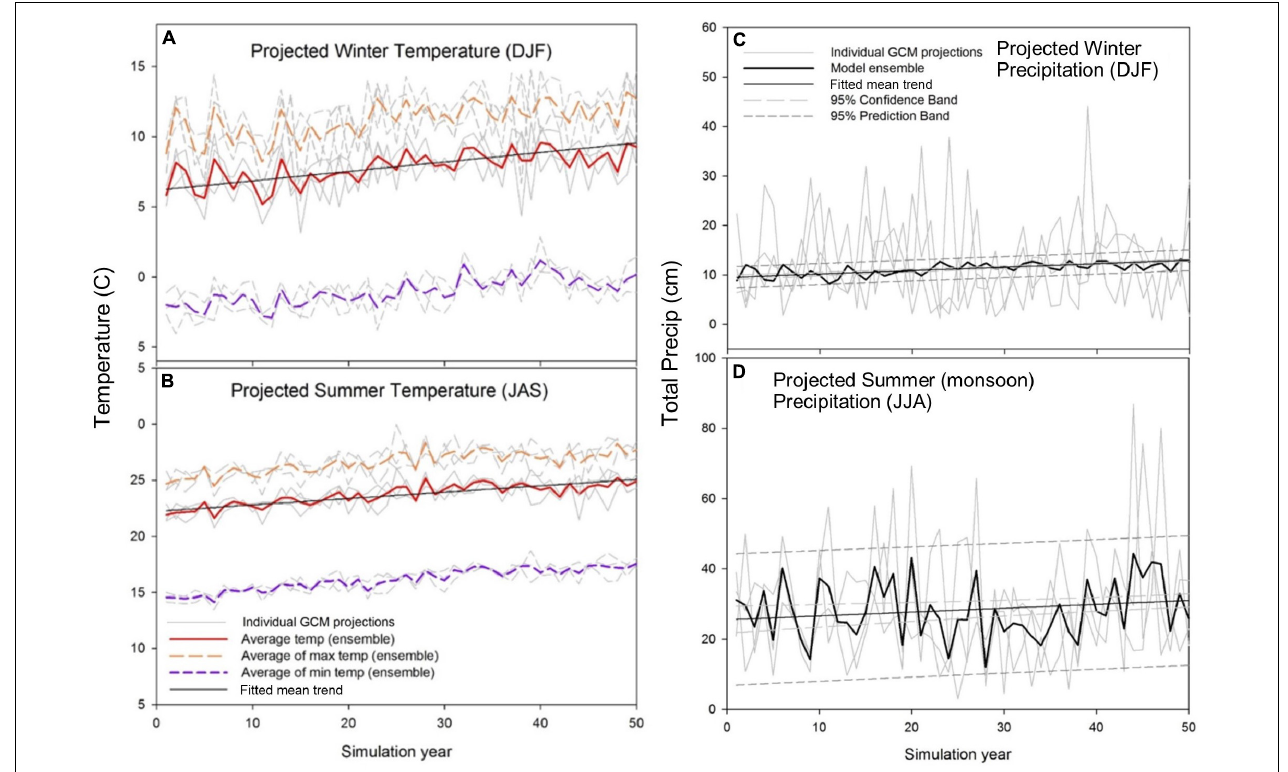
FIGURE 4 | Projected temperature and precipitation for the Huachuca Mountains, AZ, from 2005 to 2055 used for landscape model simulations. Winter temperature (A) is the daily average, and precipitation (C) is the daily total for December, January, and February. Summer temperature (B) is the daily average, and precipitation (D) is the daily total for July, August, and September. Projections are generated from the Multivariate Adaptive Climate Analogues (MACA) statistical regional downscaling of an ensemble of three CMIP5 GCMs using the RCP 8.5 scenario (Abatzoglou, 2013). The GCM subset includes the Hadley Centre HadGEM2-ES and HadGEM2-CC, and Canadian CanESM2